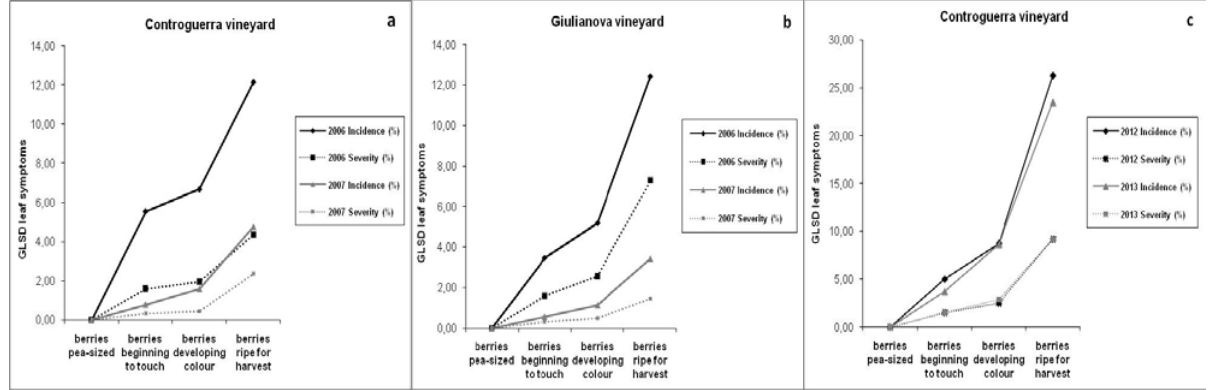
Figure 7. Incidence and severity of GLSD leaf symptoms in four growth stages in the 2006, 2007 (a, b), 2012 and 2013 (c) growing seasons in the Controguerra and Giulianova vineyards.